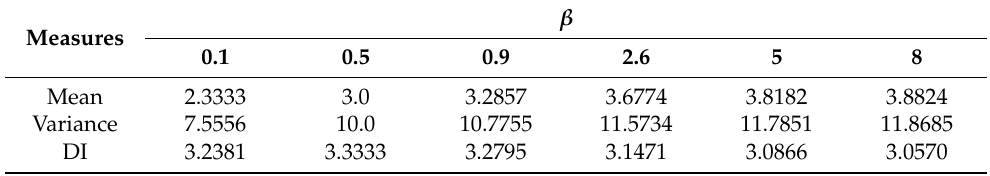
Table 2. Moment measure values for the PEE distribution for β = 1.5 and various α values.